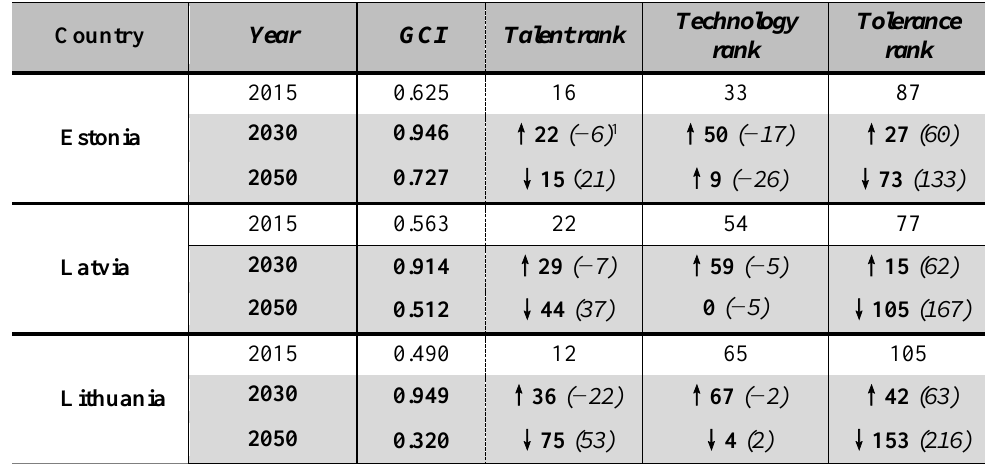
Table 2. Forecast of the GCI and its Component Rankings of the Baltic States, Main Scenario in 2030 and 2050 (authors’ elaboration based on the Eurostat data) Country Year GCI Talent rank